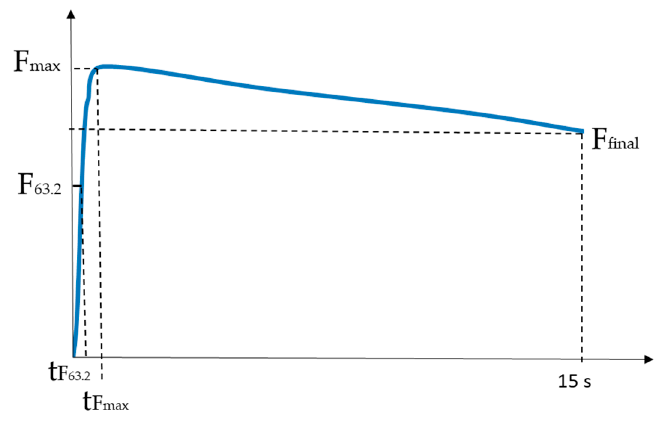
Figure 3. Proposed descriptors in a typical handgrip strength (HGS) vs. time curve. The quantities (a) to (d) defined below are introduced to quantify the di ff erent rates of change of HGS along the 15 s test. They are normalized to the maximum